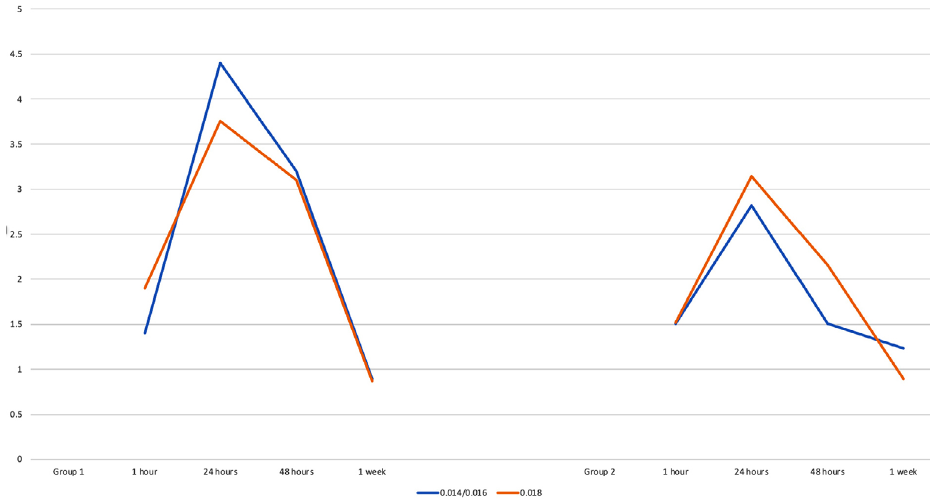
Figure 5- Pain scores associated with 0.018-inch NiTi archwire compared to 0.014-inch and 0.016-inch NiTi as initial alignment